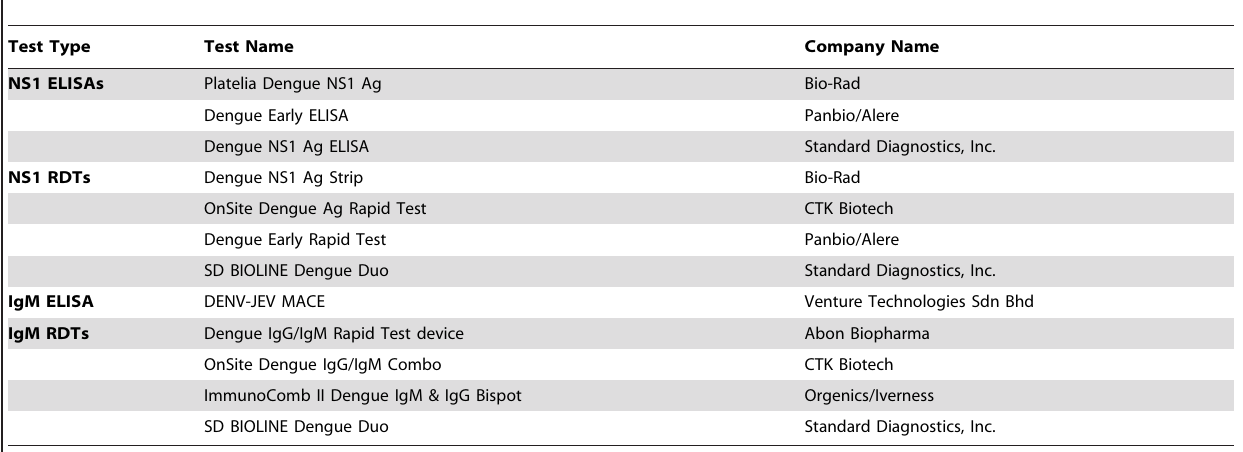
Table 3. Dengue virus NS1 antigen detection and IgM anti-dengue virus tests submitted for